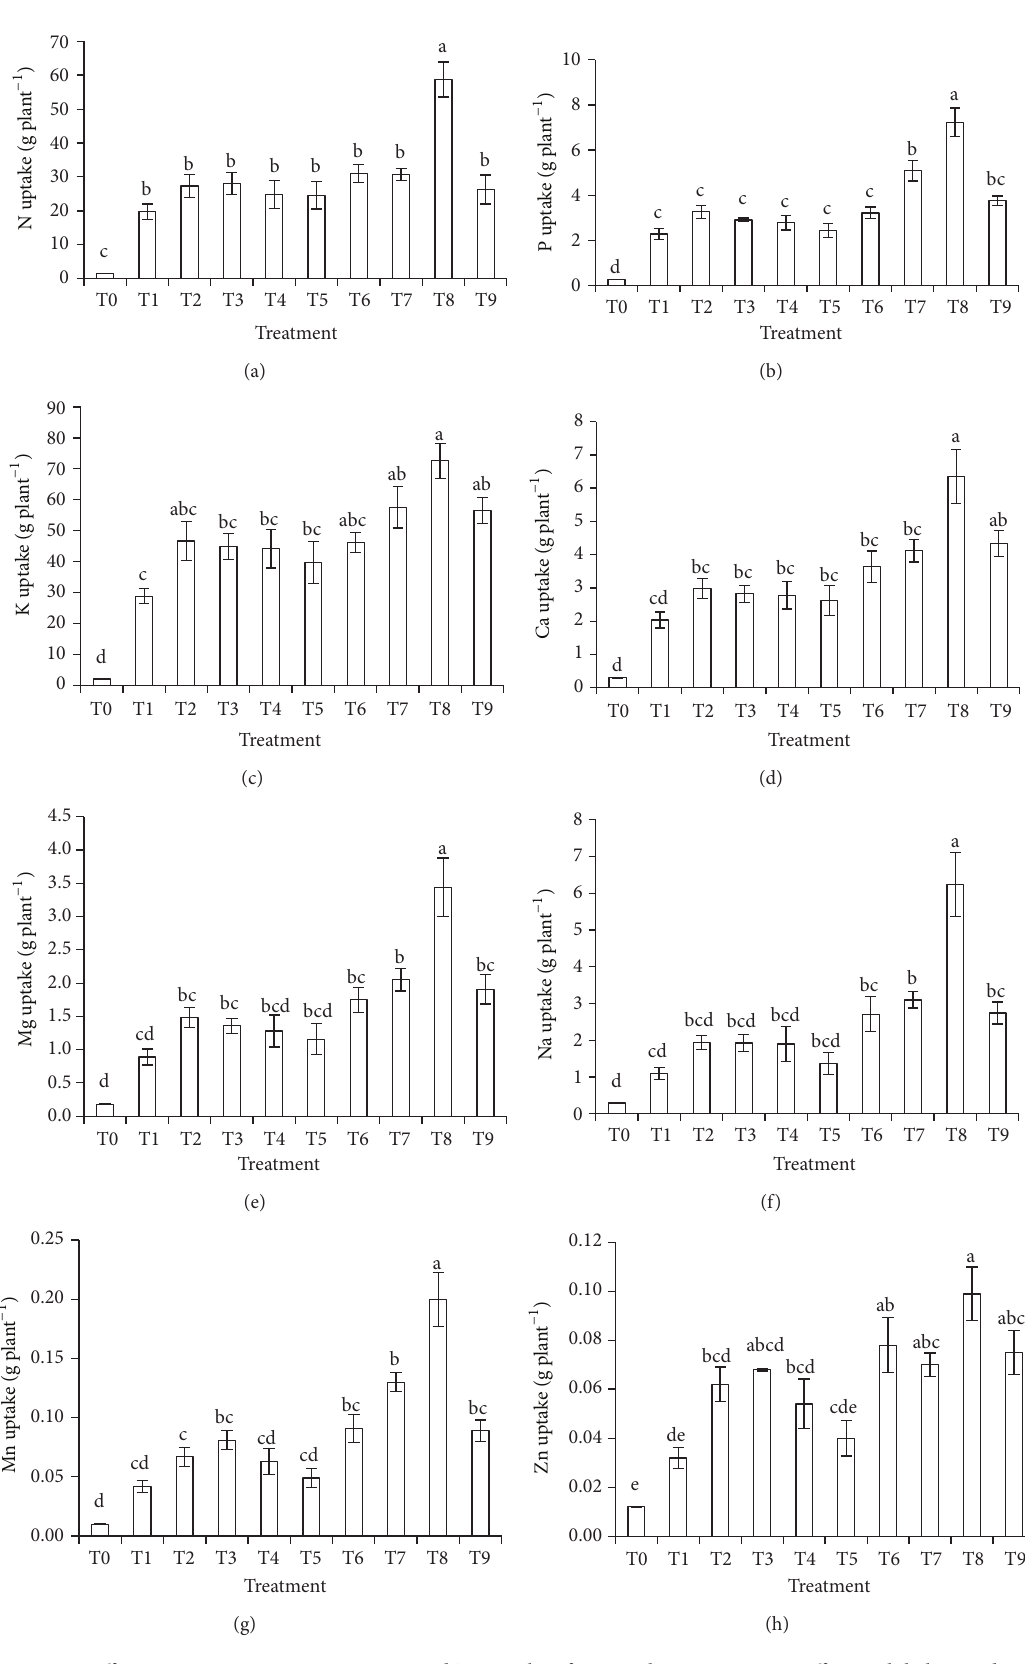
Figure 5: Treatments effects on N, P, K, Ca, Mg, Na, Mn, and Zn uptake of maize plant at 48 DAS. Different alphabets indicate significant difference between means using Tukey’s test at 𝑃 ≤ 0.05